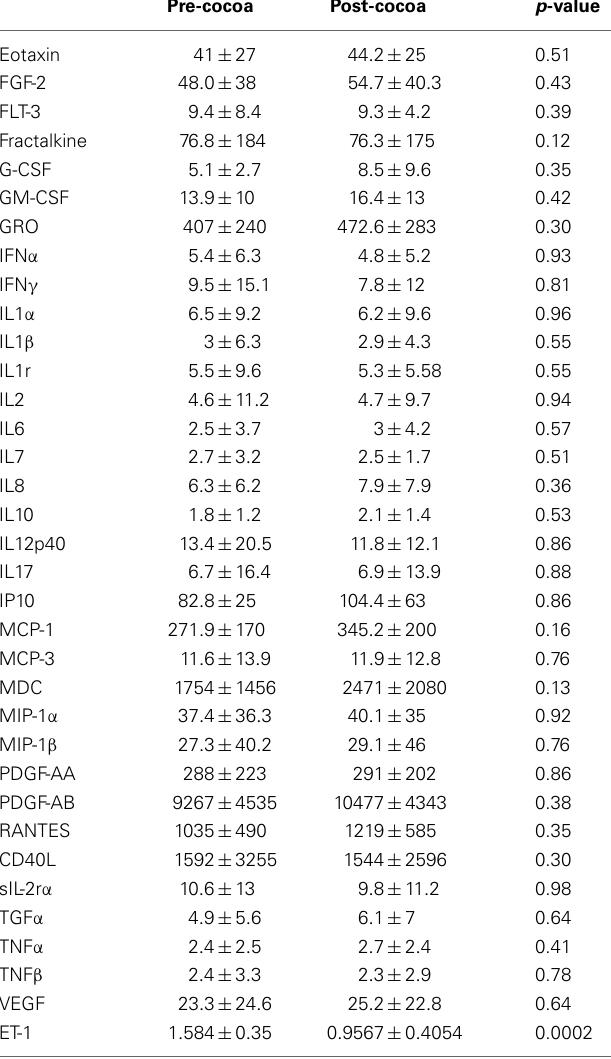
The numerical values shown in the table represent means ( ± standard devia- tion). Concentrations are given in pg/ml.